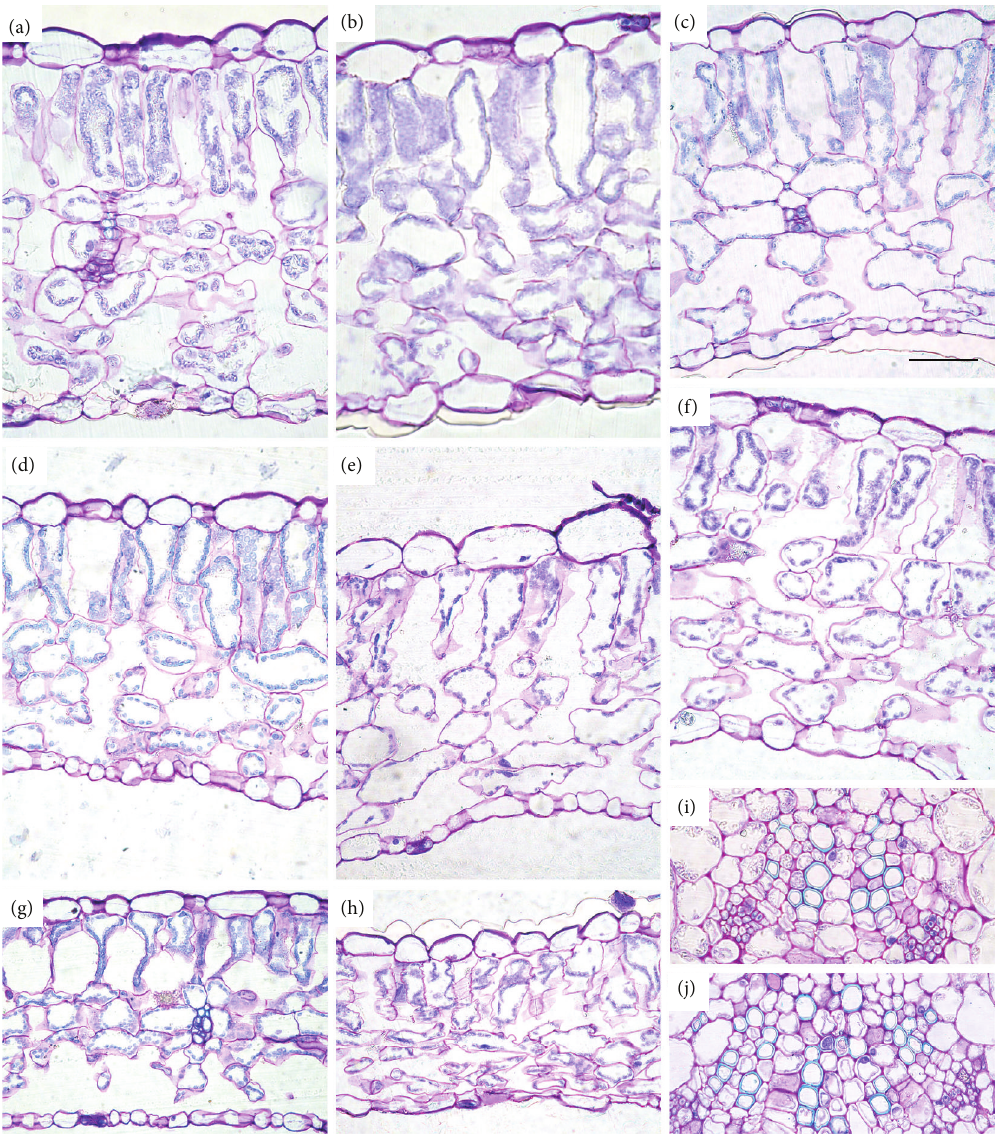
Figure 3: Light microscopy views of cross sections of leaf lamina of S. lycopersicum L. “Microtom” compound leaves from plants developed from control (a) and irradiated seeds: 0.3 Gy (b), 10 Gy (c), 20 Gy (d), 50 Gy (e, g), and 100 Gy (f, h). Detail of xylem in the main vein is